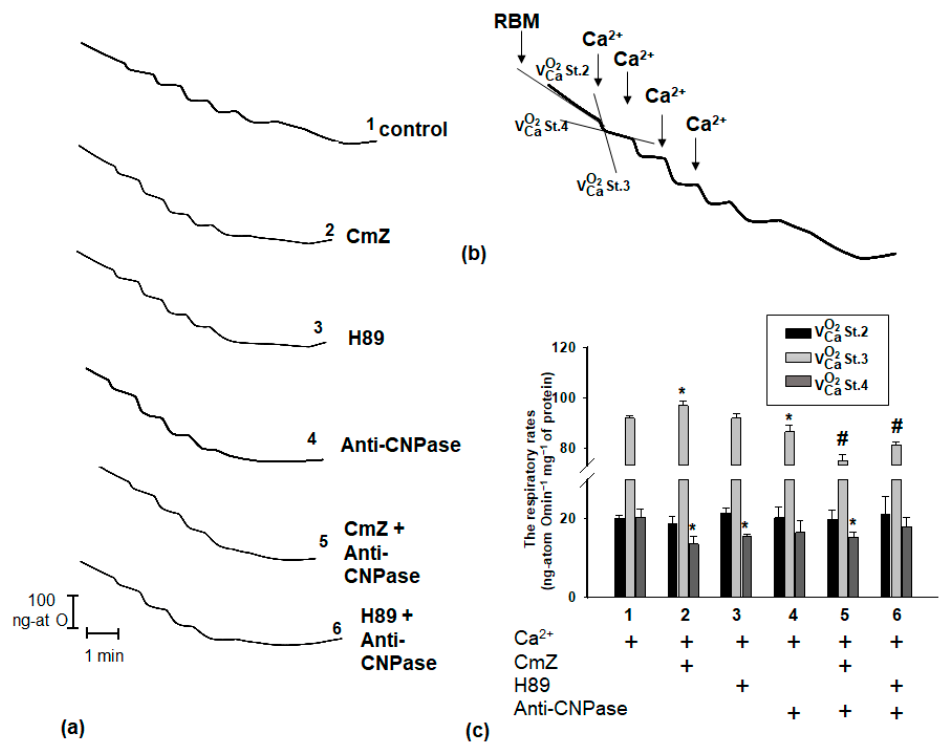
Figure 2. Effect of CmZ, H89, and anti-CNPase antibody, and their combined effect on respiratory activity in RBM. The conditions were the same as in Figure 1. ( a ) Representative curves of respiratory activities. ( b ) A schema of calculation of oxygen consumption in states V O2 Ca St.2, V O2 Ca St. 3, V O2 Ca St. 4. ( c ) Quantitative analysis of respiratory activity in the presence/absence of CmZ (30 µ M), H89 (5 µ M), and anti-CNPase antibody (0.18 µ g/mL). The values shown are the means ± SD from three independent experiments; * p ≤ 0.05 versus respiratory activity without any additions, # p ≤ 0.05 versus respiratory activity in the presence of anti-CNPase antibody.